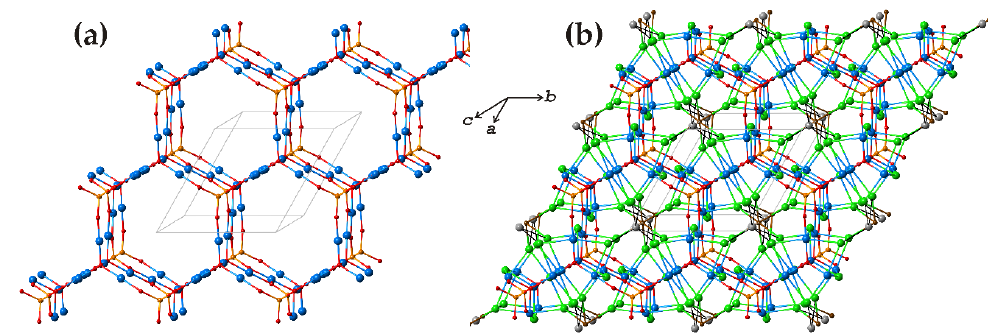
Figure 9. The open framework metal-oxide framework formed by [O 2 Cu 7 ] dimers and (SeO 3 ) groups in the crystal structure of burnsite ( a ) and the projection of the whole structure of burnsite featuring filling framework cavities by Cd 2+ , K + , and Cl − ions ( b ). Legend: Cu, Se, O, Cl, K, and Cd atoms are shown as blue, orange, red, green, gray, and brown spheres, respectively.